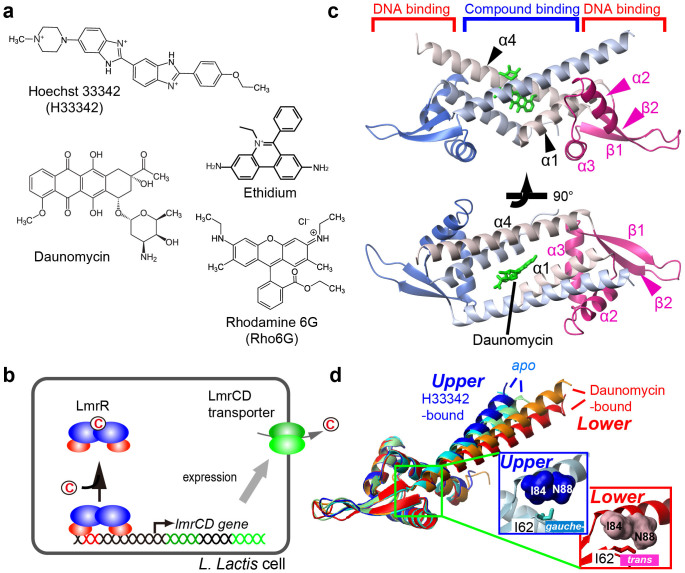
Substrate, regulatory mechanism, and structural features of LmrR.(a), Chemical structures of compounds that bind to LmrR. (b), Schematic representation of gene regulation by LmrR. (c), Ribbon diagrams of LmrR in complex with daunomycin. The compound (green sticks) binds to the pore at the dimeric center. (d), Different orientations of the C-terminal α4 helix relative to the wHTH motif. A superposition of the apo (cyan and light green), H33342-bound (blue), and daunomycin-bound (orange and red) LmrR subunit structures is shown. Inset: Close-up view of the hinge region. Ile-62 sidechain is shown as sticks while Ile-84 and Asn-88 are shown in surface representations.